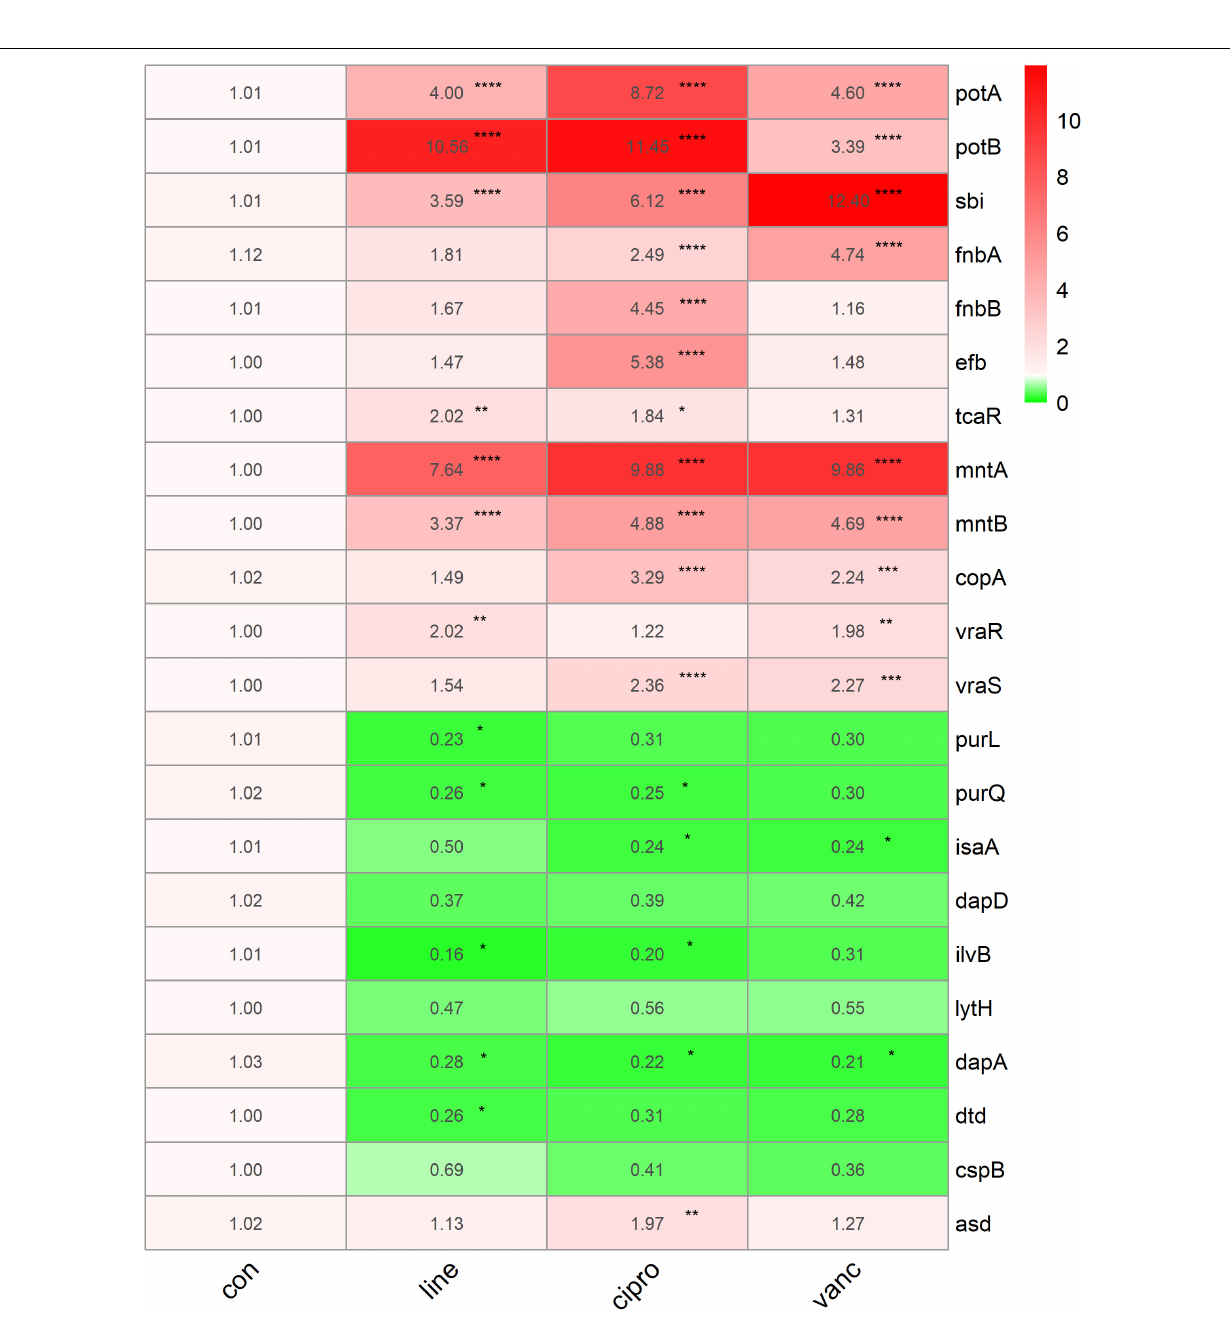
adaptive transcriptional expressions may be associated with biofilm resistance to